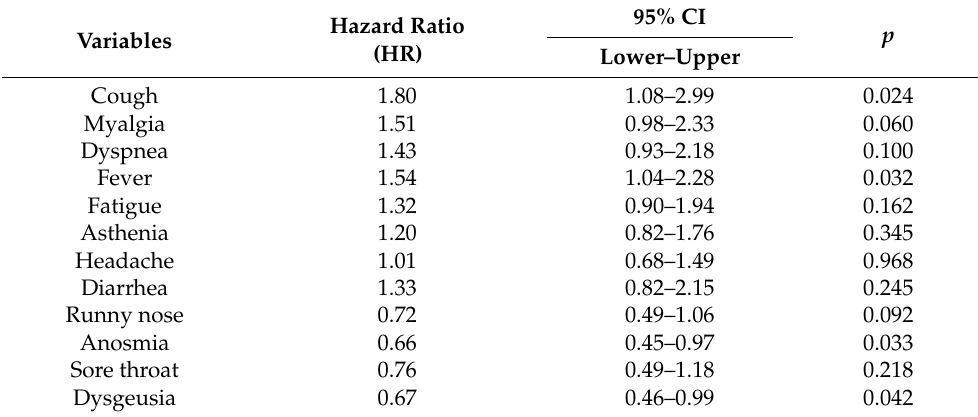
Table 4. Univariate analysis of the risk of remaining with fatigue according to COVID-19 symptoms in G1 ( n =